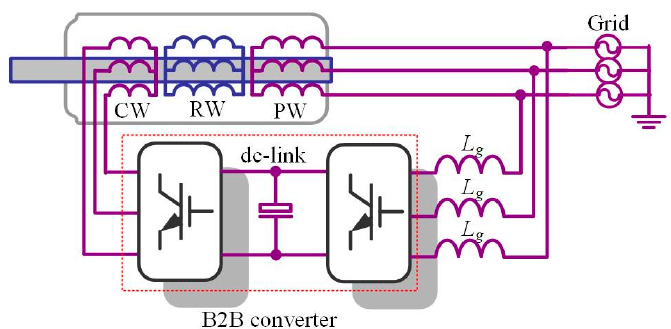
Figure 1. The overview of the BDFIG wind power system. CW: Control-Winding; RW: Rotor-Winding; PW: Power-Winding.